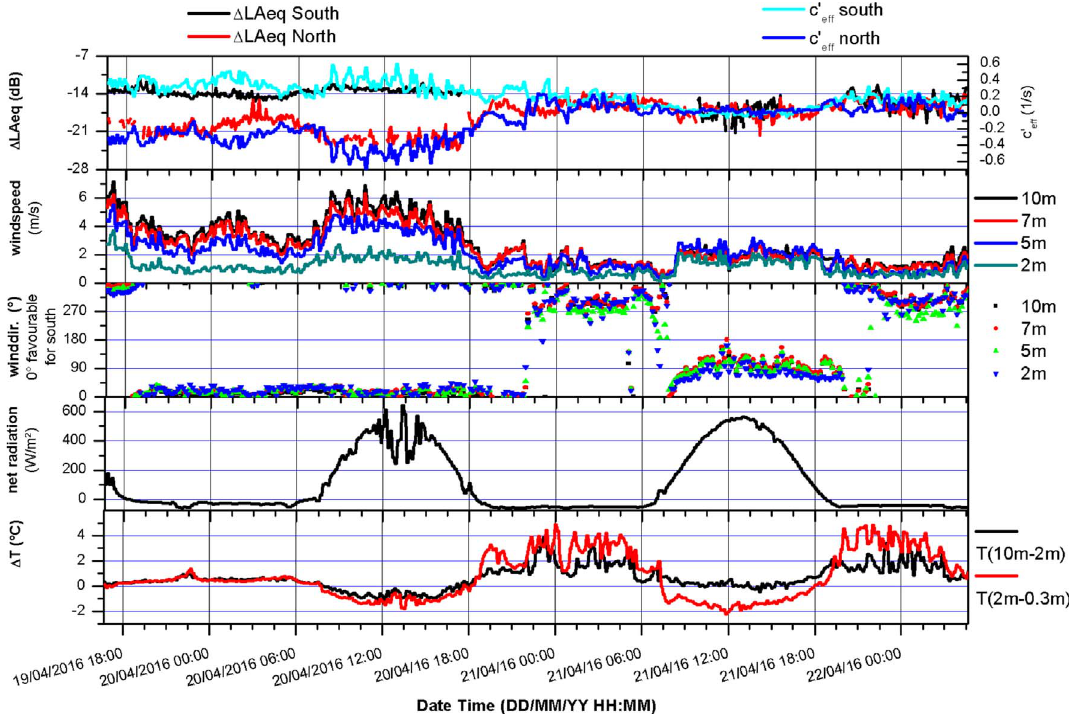
Figure 7. Bad Voeslau: D L A ,eq,200m and the effective sound speed gradient on both sides of the motorway with meteorological data.